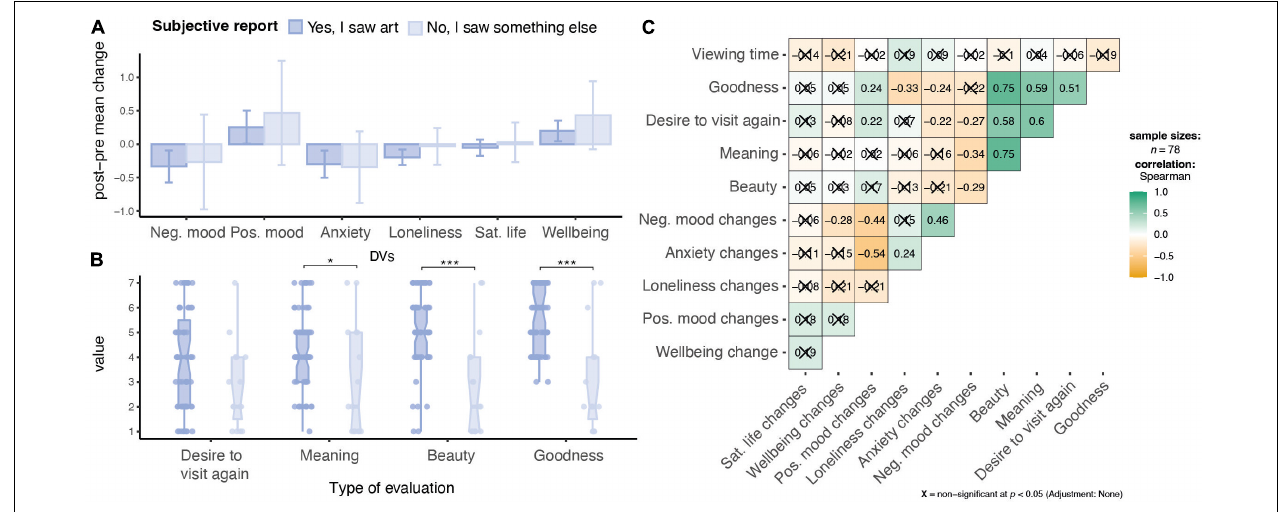
FIGURE 4 | Subjective experience of participants, including (A) DV changes grouped by perception of if participants considered they say art or not, bar plots showing the breakdown of changes in Wellbeing DVs. Error bars represent 95% CI. (B) Box plots showing the breakdown of the aesthetic ratings grouped by subjective reports (i.e., seeing art), Error bars represent SD. * p < 0.05, *** p < 0.001. p -values uncorrected. (B) Appraisals shown broken down by I saw art or not. (C) Correlations between viewing time, appraisals and changes in Wellbeing DVs. Correlation plot was computed using ggstatplot (Patil,